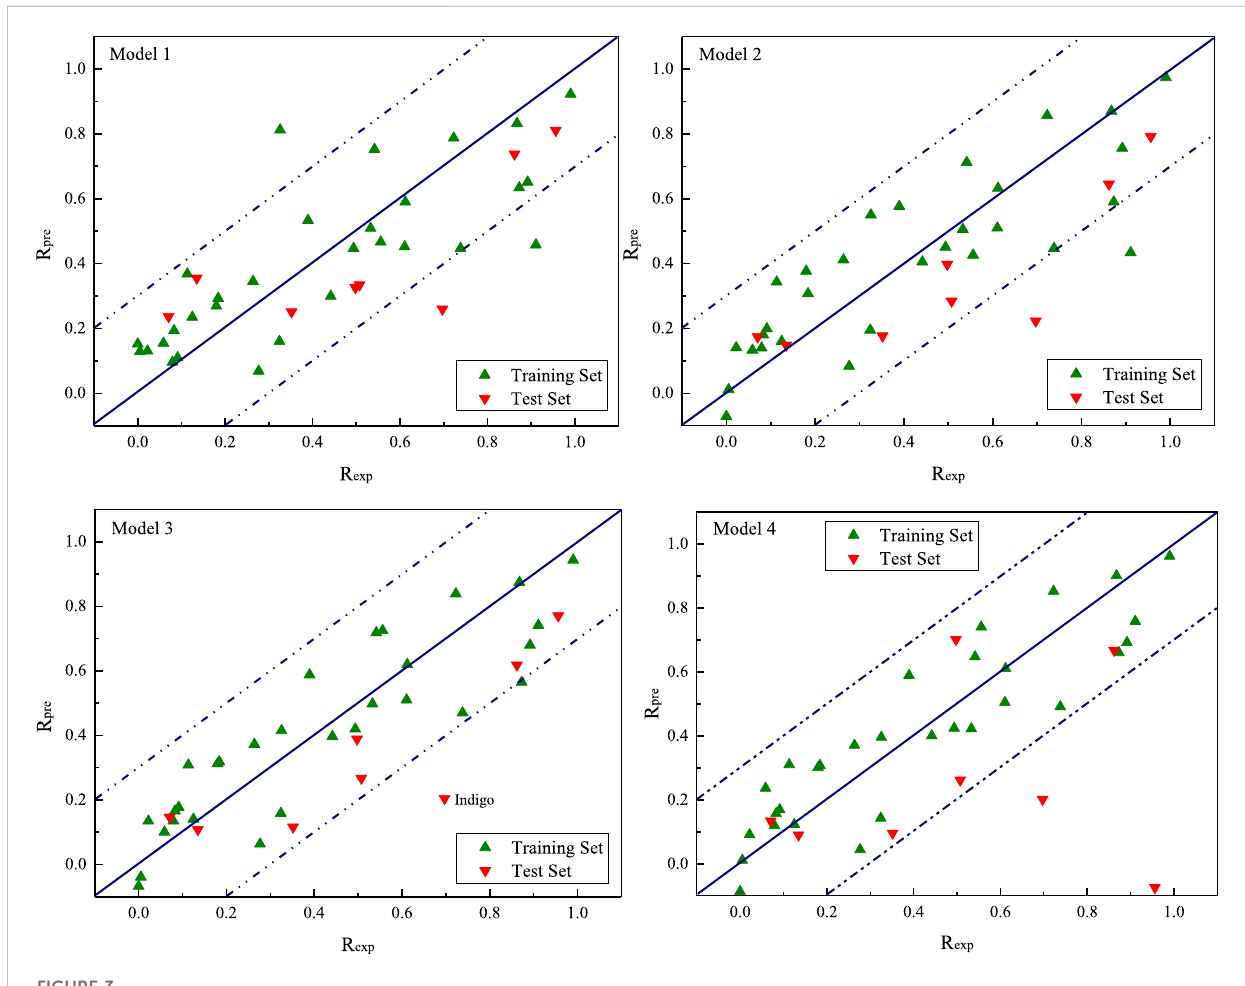
FIGURE 3 Experimental R exp versus predicted R pre derived from the QSAR model for AlCl 3 under alkaline conditions.